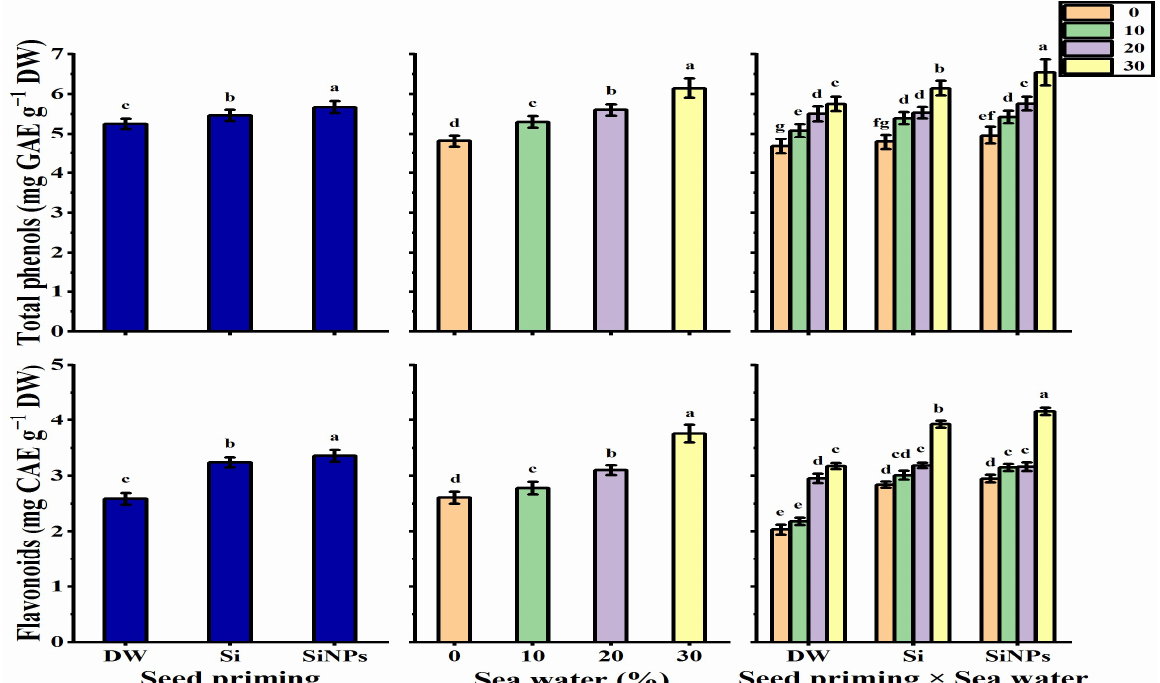
Figure 6. Effect of seed priming on total phenols (mg GAE g − 1 DW) and flavonoids (mg CAE g − 1 DW) contents of Lathyrus odoratus leaves irrigated with seawater levels (0, 10, 20, and 30%). Data are mean value ± SE. Bars with different letters are significantly different at p ≤ 0.05 level.